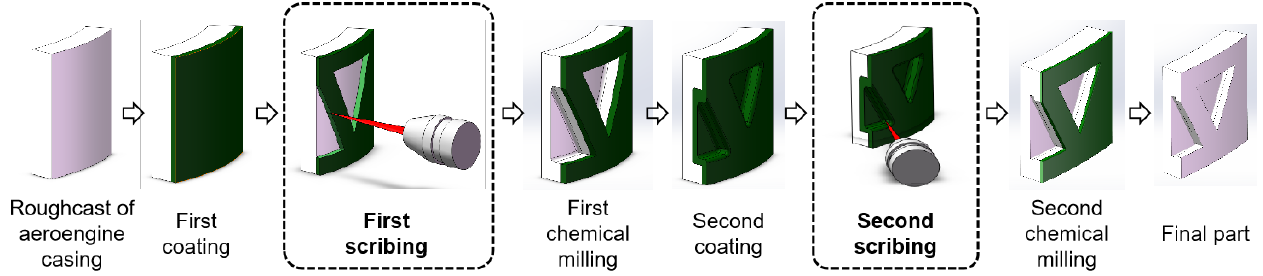
Figure 1. Manufacturing process of chemical milling parts.